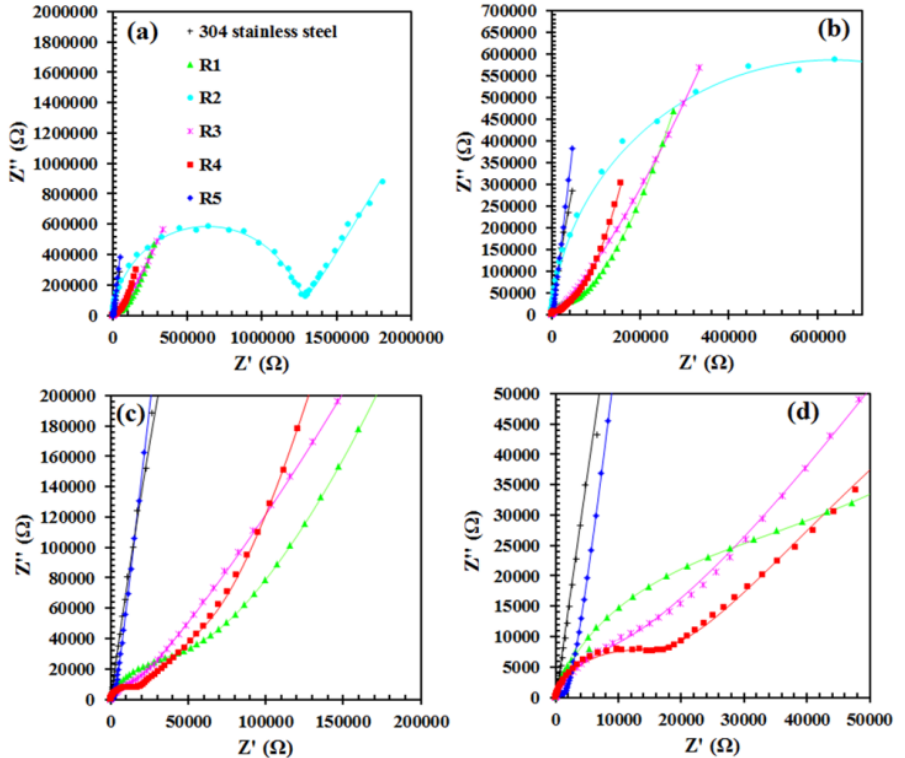
Figure 7. ( a – d ) Nyquist plots of 304 stainless steel and samples R1-5. Raw data (symbols) and fitted data (solid lines).